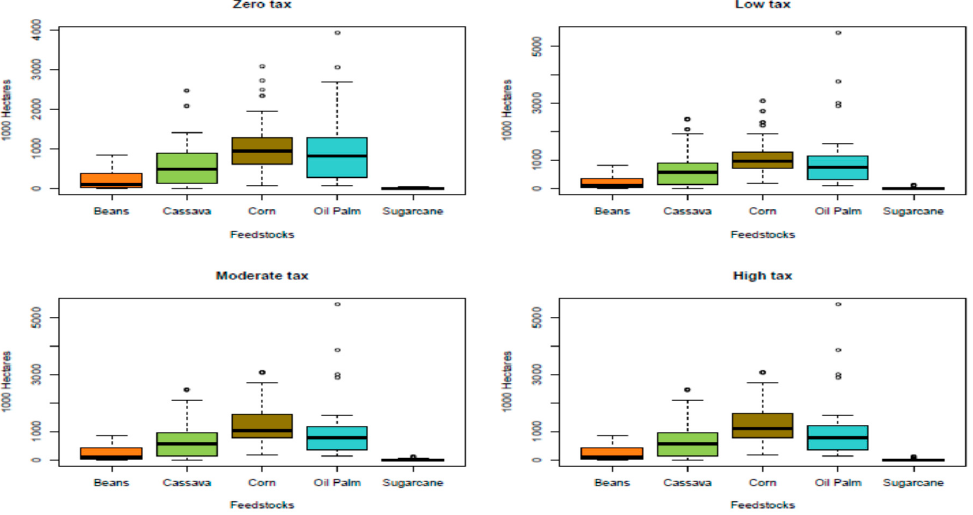
Figure 2. Bioenergy feedstock area by 2050 under subsidy action.